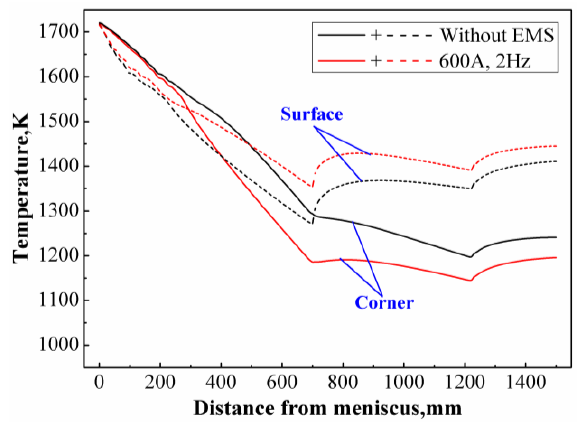
Figure 10. Temperature variations at the centerline of the bloom wide face and chamfered corner.